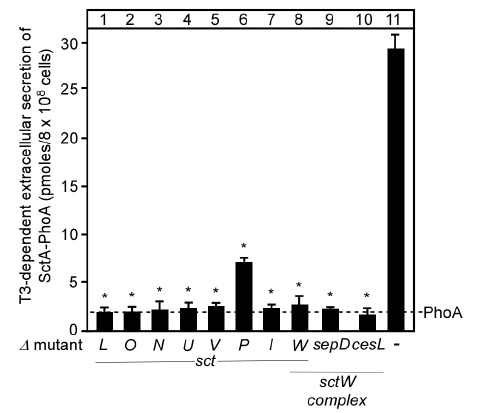
Figure 2. SctA-PhoA requires T3SS components for secretion. Quantification of SctA-PhoA secreted in the spent growth medium (as in Figure 1C) in different EPEC gene-deletion strains. Letters indicated the deleted gene (as in Figure 1A). Bar graphs with SEM are shown; n = 3 biological repeats. Unpaired parametric t -test was performed, *: p < 0.01.